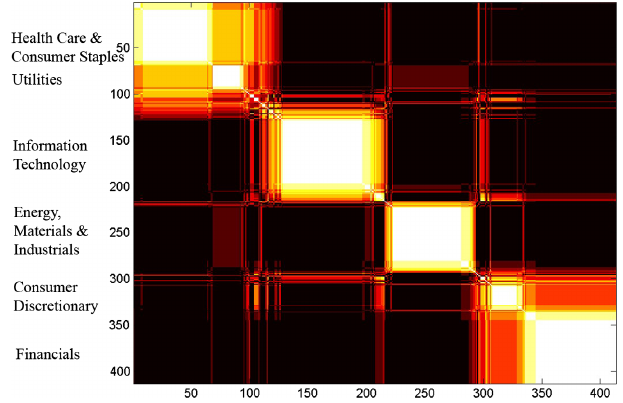
FIG. 15. Multifrequency heat map showing the normalized co-occurrence of different pairs of stocks within the same community, for the same time period but over various temporal resolutions of the original time series (white: unit frequency; black: zero frequency). The stocks have been ordered using simulated annealing to position stocks with a high degree of cross-correlations next to each other. To further inform the graph, the GICS sectors have been specified, emphasizing which groupings of stocks tend to associate with a particular sector. Overall, the blocks of large black and white areas indicate a high degree of coherence of the communities at different resolutions. However, there are two groups of soft stocks, one alternating across Utilities, Health Care, and Consumer Staples, and one alternating across Consumer Discretionary and Financials (produced using the Louvain